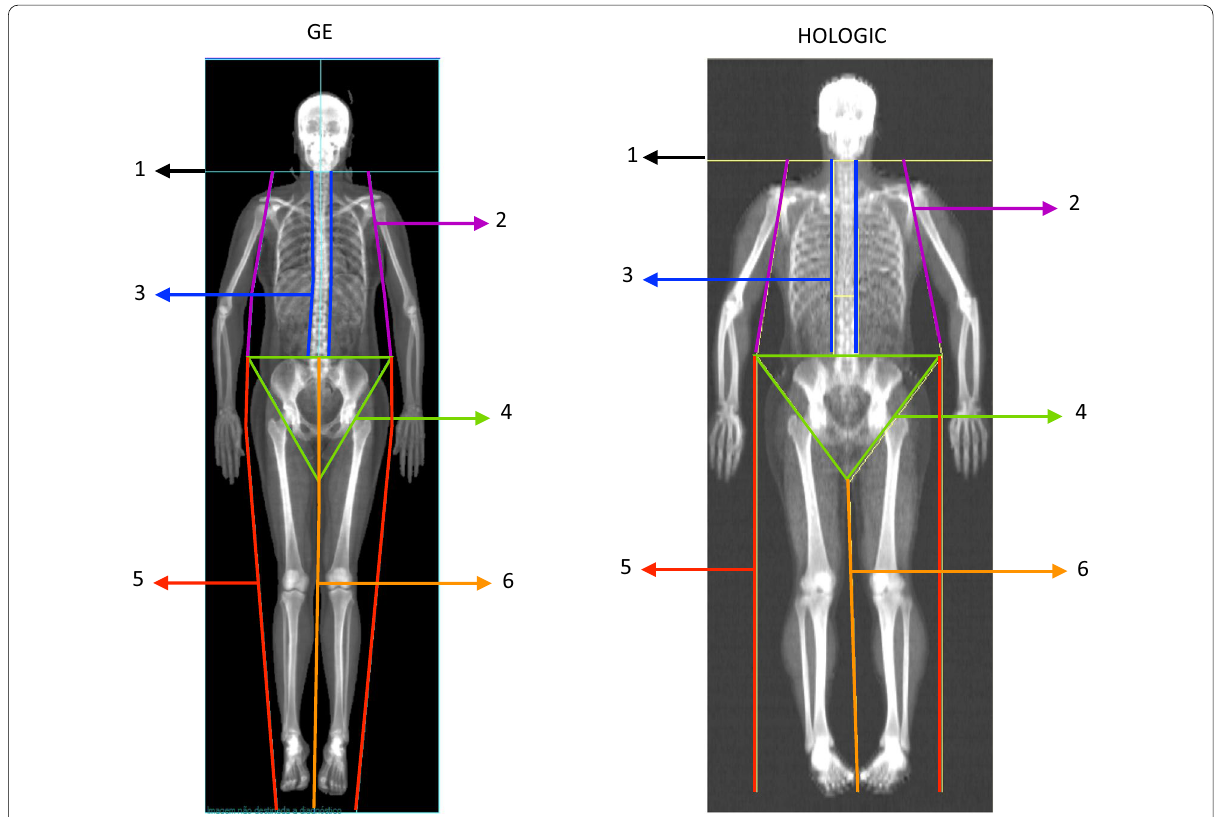
Fig. 9 Analysis and positioning of ROI lines according to